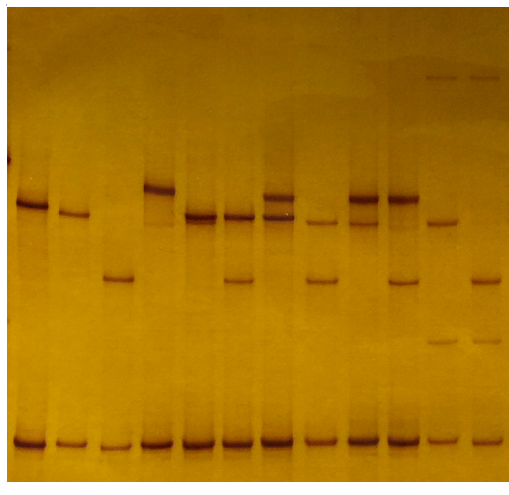
Figure 3. PCR-SSCP analysis of sheep KRTAP21-2 . Different banding patterns came about from